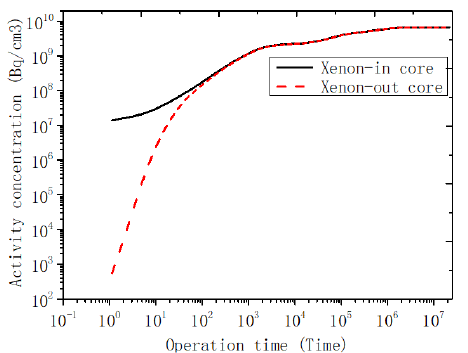
Figure 3. Schematic diagram of 2MW MSR system Figure 1. Reactor core model(Top view) Table 2. Verification of static burnup simulation results with ORIEGNS Bq \